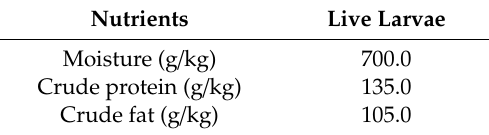
Table 1. Nutritional composition of live larvae (as in basis, provided by supplier).